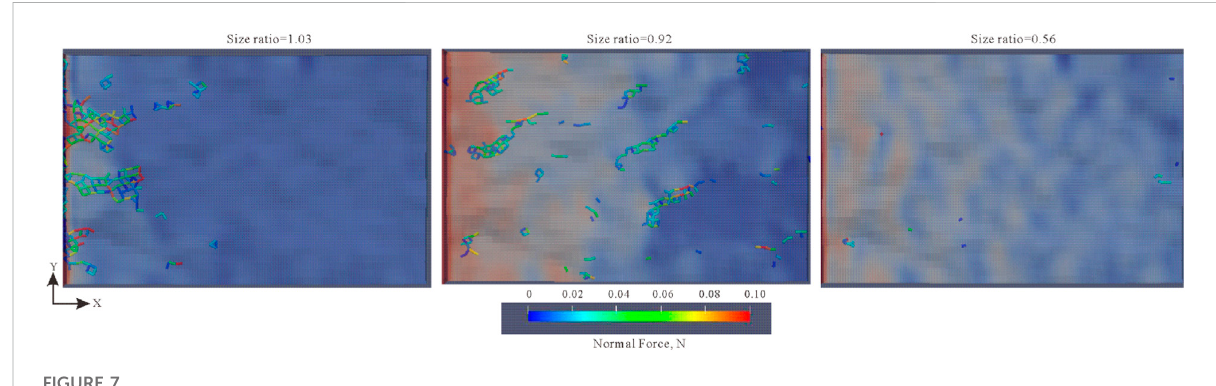
FIGURE 7 Force chain structure of plugging formed by different sizes of particles in